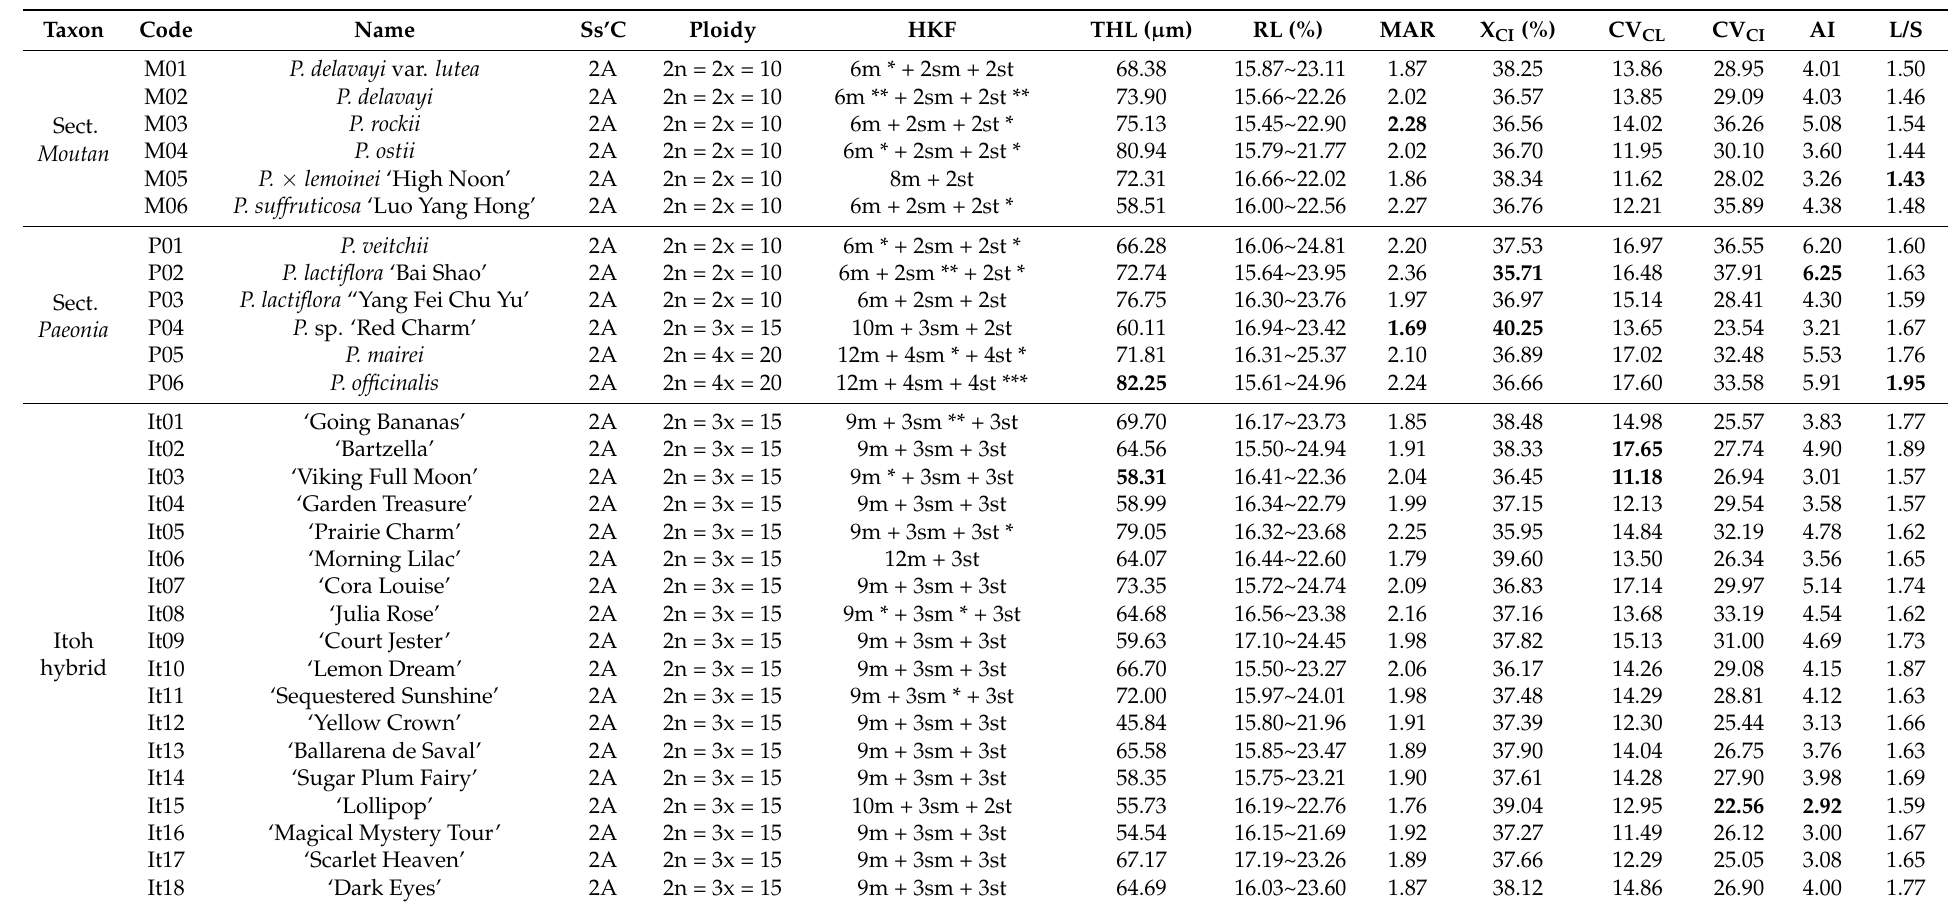
Table 2. Collecting information of materials and cytogenetics